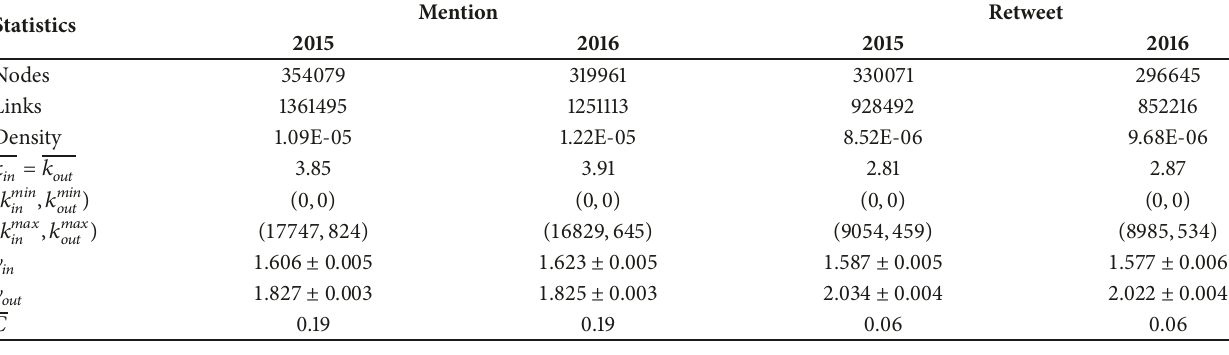
Table 3: General statistical properties of the retweet and mention networks aggregated for the whole period of study for both electoral campaigns. 𝑘 𝑖𝑛(𝑜𝑢𝑡) corresponds to in- (out-) degree and 𝛾 𝑖𝑛(𝑜𝑢𝑡) to the exponent of the correspondent degree distribution. The confidence intervals in the power law exponents calculations correspond to 2𝜎 .